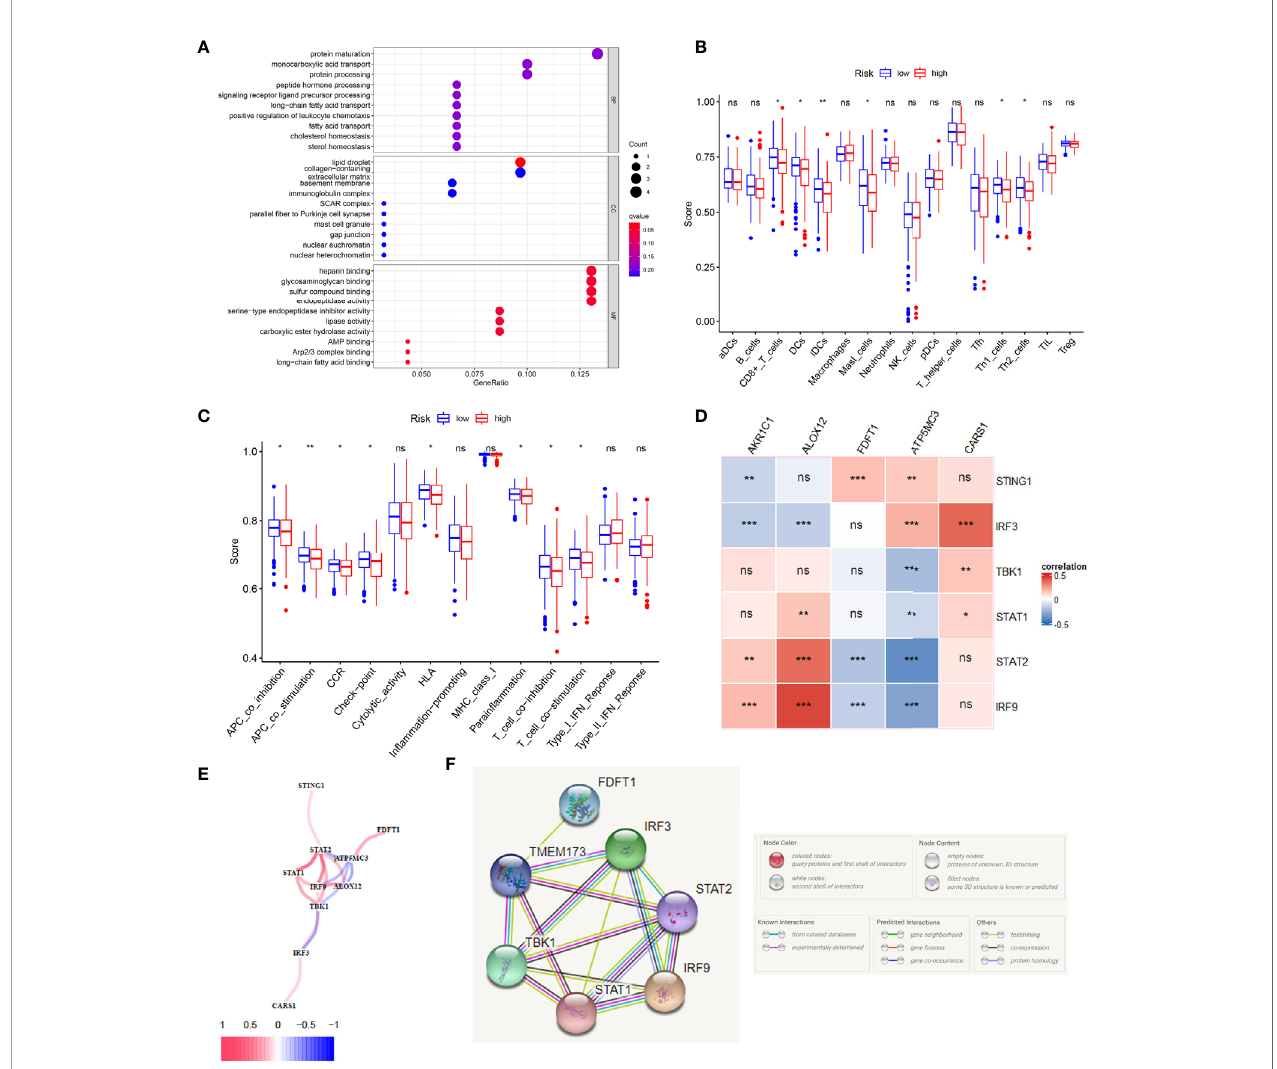
FIGURE 5 | The immune status difference between high risk and low risk in colon cancer patients. (A) The GO enrichment analysis between high-risk and low-risk groups in colon cancer. (B) The immune cell between high-risk and low-risk groups in colon cancer; *P <0.05; **P <0.01; ***P <0.001. (C) The immune related function between high-risk and low-risk groups in colon cancer; *P <0.05; **P <0.01; ***P <0.001. (D) The correlation between STING related genes and ferroptosis related genes in CC using the Pearson coef fi cient; *P <0.05; **P <0.01; ***P <0.001; ns, no signi fi cance. (E) The predicted gene interactions between STING related genes and ferroptosis related genes based on the RNA-seq data of TCGA cohort in CC. (F) The protein-protein interactions (PPI) network of above